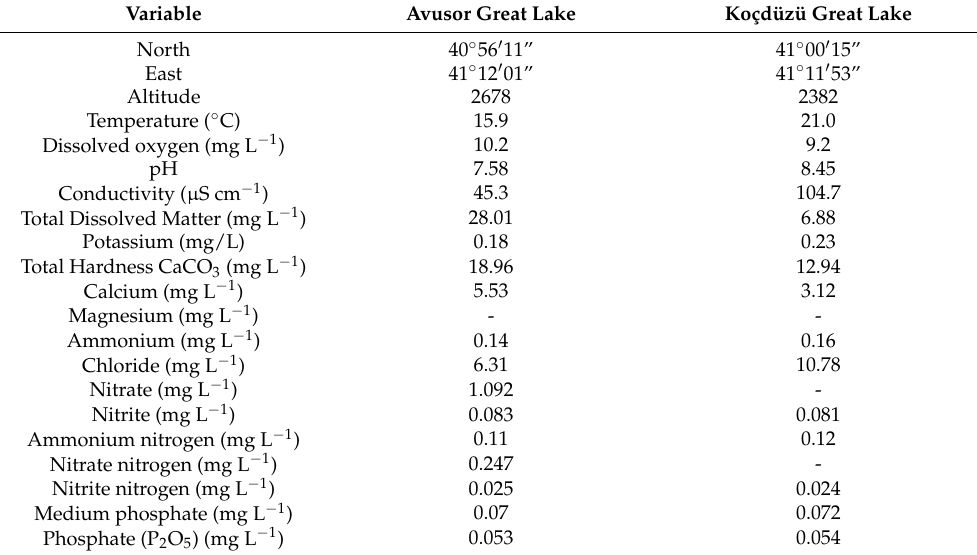
Table 1. Averaged physical and chemical data, GIS coordinates and altitude of the Avusor Great Lake and Koçdüzü Great